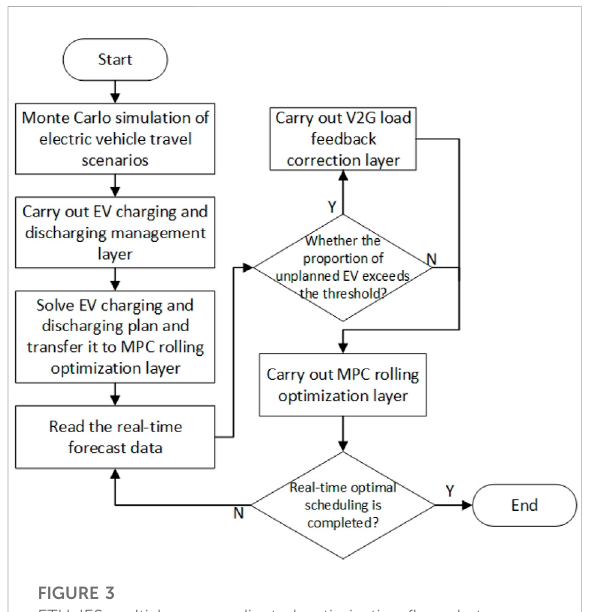
FIGURE 3 ETH-IES multi-layer coordinated optimization fl ow